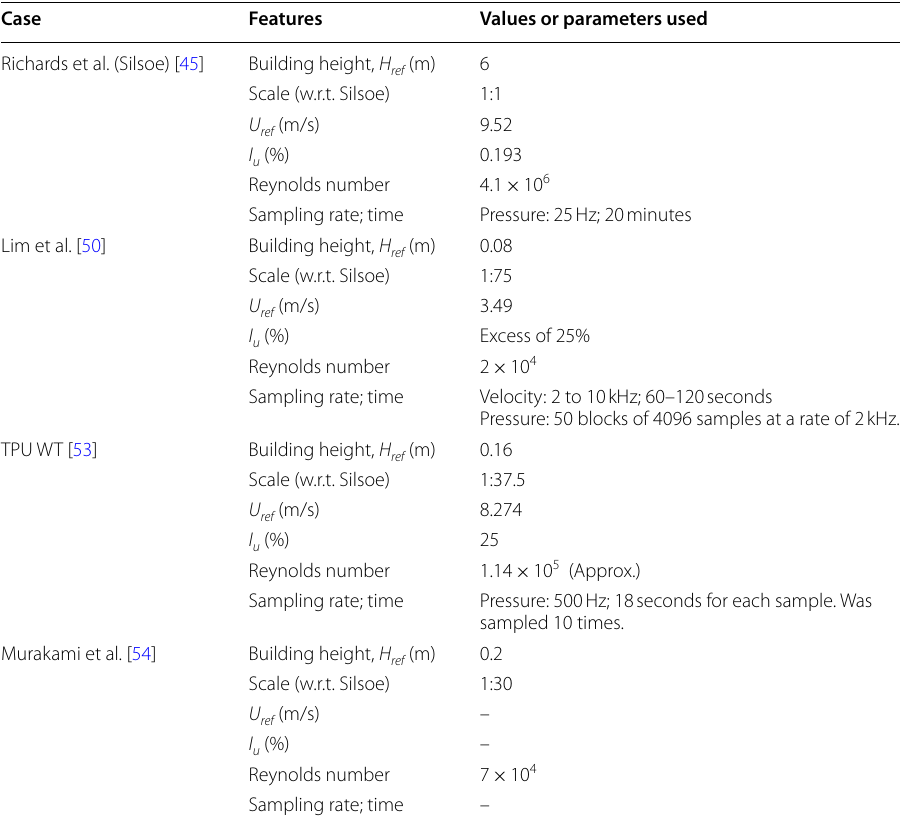
Table 1 Flow characteristics in different experiments Case Features Values or parameters